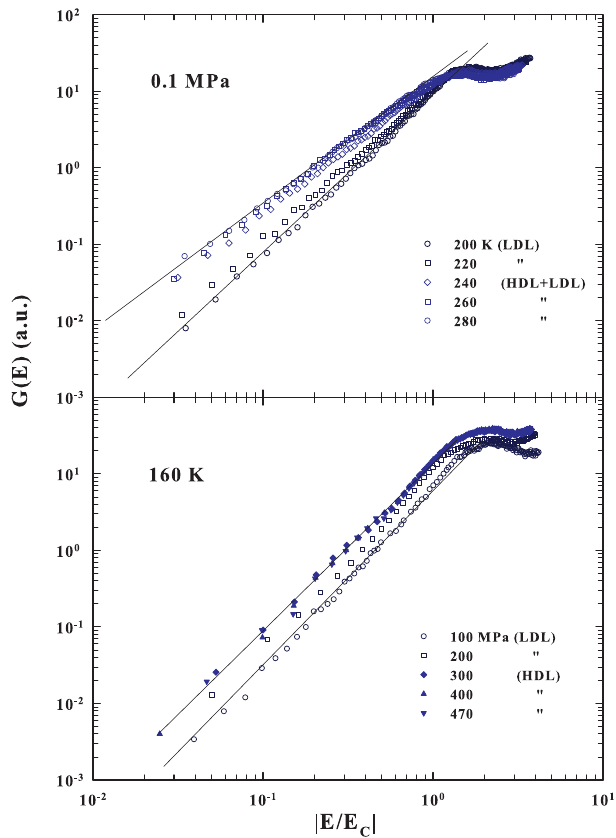
Figure 4. (Top side) A log-log representation of the energy scaled DOS ( G ( E ) vs. | E / E C | ) obtained from the INS spectra for confined water at the ambient pressure and several temperatures above and below the corresponding temperature of the FSDC (about 223 K). The bottom side instead deals with the same representation of the scaled G ( E ) for a fixed temperature of 160 K and different pressures in the range 100 < P < 470